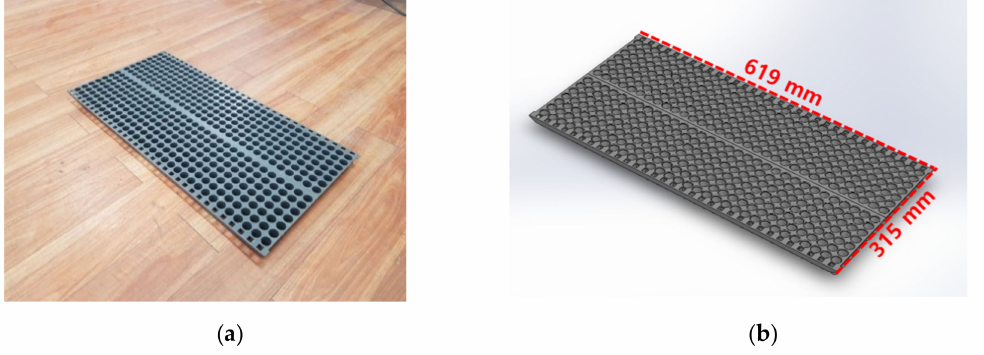
Figure 4. Shape of pot tray: ( a ) picture and ( b ) 3D model.